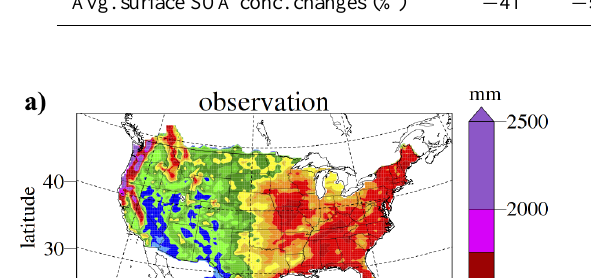
Mass fraction lost by gas-phase dep. (%)